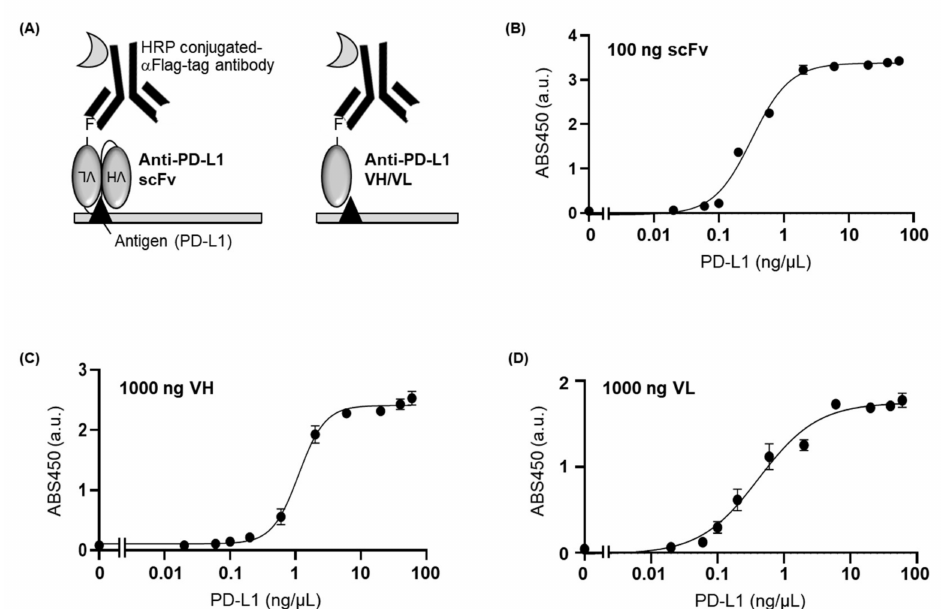
Figure 3. ( A ) Schematic representation of the indirect ELISA for confirming the dose-dependent PD-L1-binding efficiency of recombinant antibody fragments; ( B ) ELISA signal of 100 ng anti-PD-L1 scFv with various concentrations PD-L1; ( C ) ELISA signal of 1000 ng anti-PDL1 VH with various concentrations PD-L1; ( D ) ELISA signal of 1000 ng anti-PD-L1 VL with various concentrations of PD-L1. Error bars represent ± 1 SD (n =